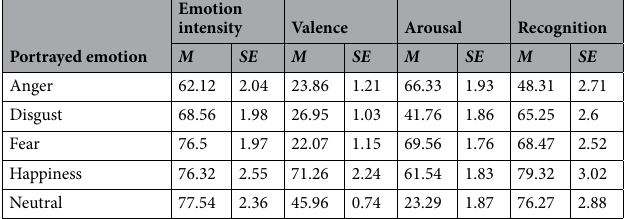
Table 3. Means and standard errors for emotion intensity, valence, arousal, and recognition. All indices were measured on a scale from 1 to 100.